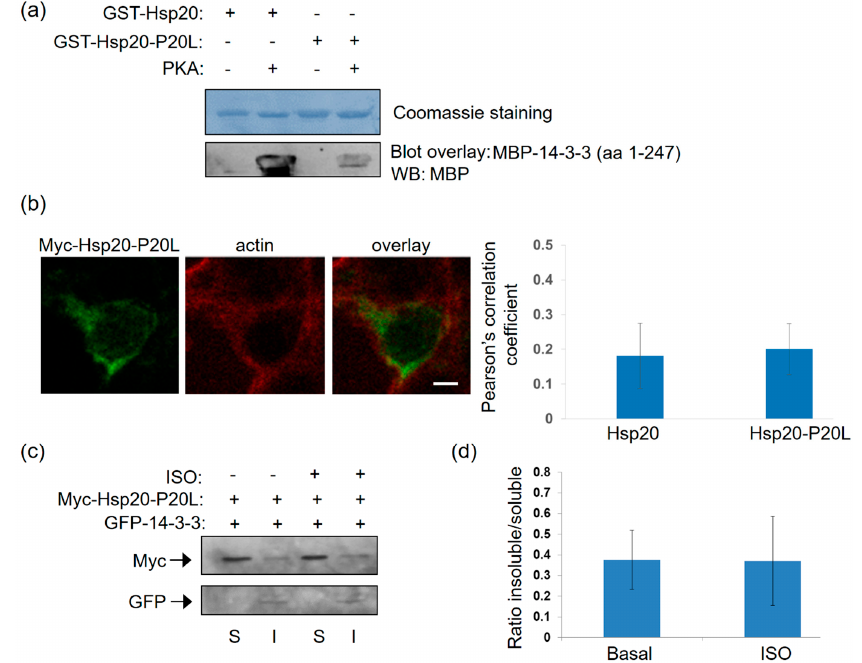
Figure 5. The human P20L mutation in Hsp20 inhibits its association with 14-3-3. ( a ) Coomassie staining of GST-Hsp20 recombinant proteins. Blot overlay assays using GST-Hsp20-WT or P20L and MBP-14-3-3 determine diminished binding of PKA-treated P20L mutant protein to 14-3-3. No unspecific binding to MBP was observed in control experiments (Figure S1). ( b ) Immunofluorescence analysis of HEK 293 cells transfected with myc-Hsp20-P20L and examination of its localization with the cytoskeletal marker, actin. Calculation of Pearson’s correlation coe ffi cient determined no significant alteration in the subcellular distribution of myc-Hsp20-P20L, when compared to myc-Hsp20. Data are the mean ± SD; n = 15 cells from each group. Scale bar 5 µ m. ( c ) Fractionation of 1 µ M ISO treated HEK 293 cells transfected with myc-Hsp20-P20L and GFP-14-3-3 determines no significant alteration of myc-Hsp20-P20L subcellular location. ( d ) Quantification of myc-Hsp20-P20L distribution in the presence GFP- 14-3-3. Data are the mean ± SD; n =